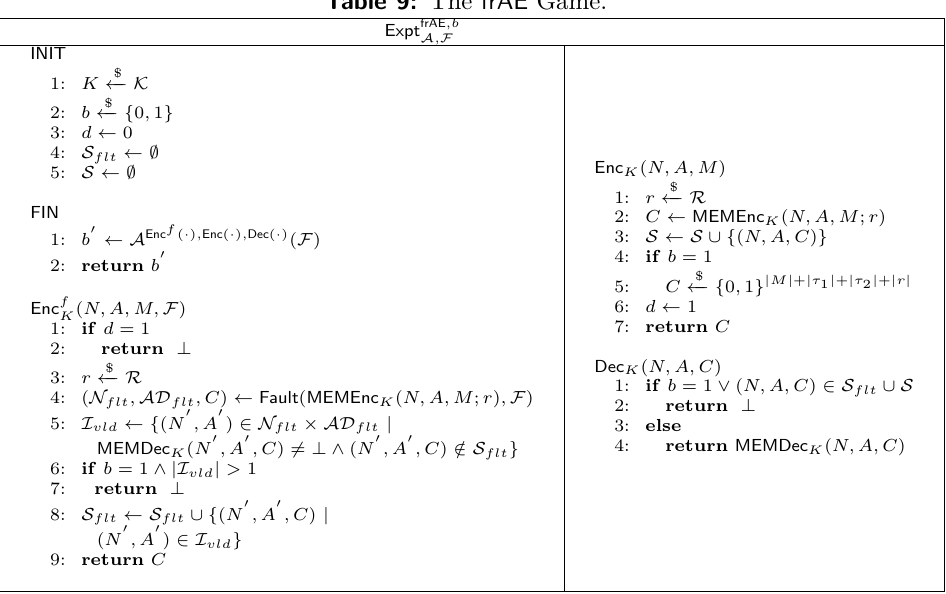
Table 9: The frAE